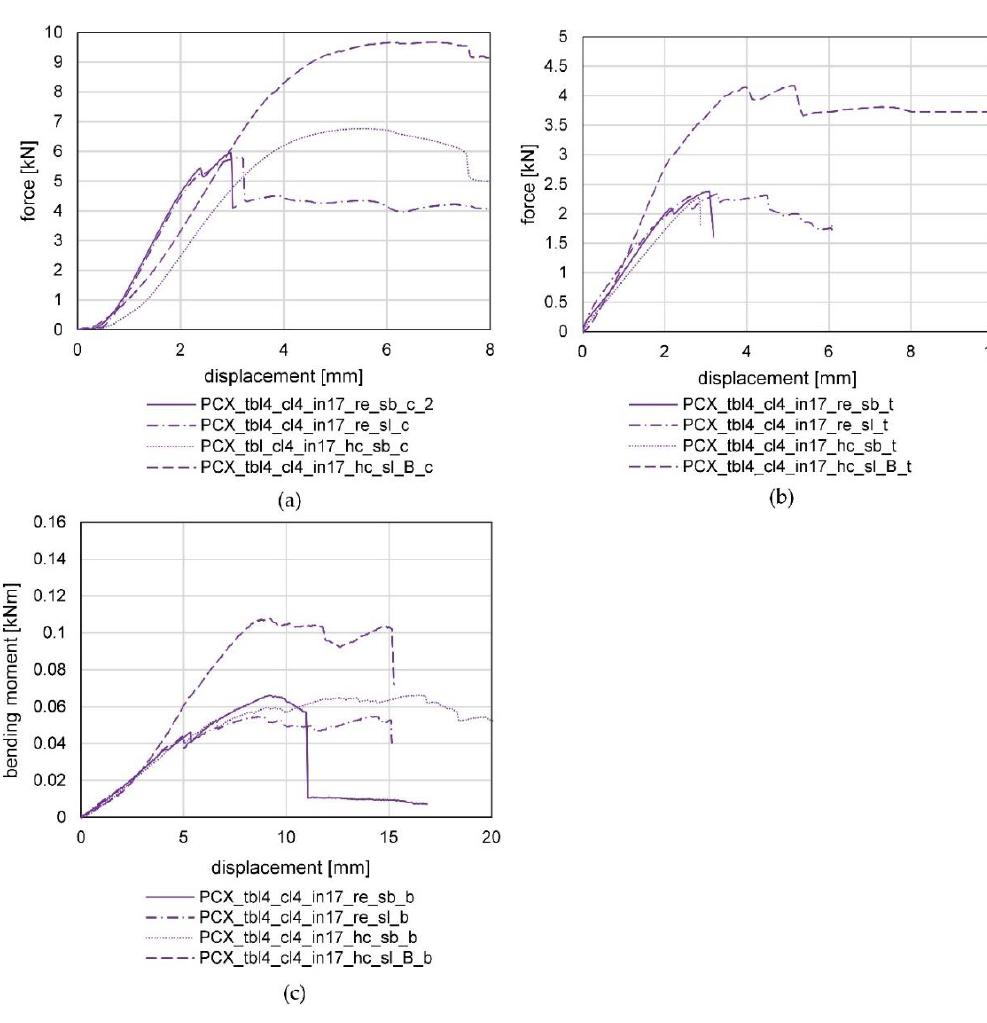
Figure 9. Results of the ( a ) compression tests; ( b ) tension tests; ( c ) bending tests, of series 2.